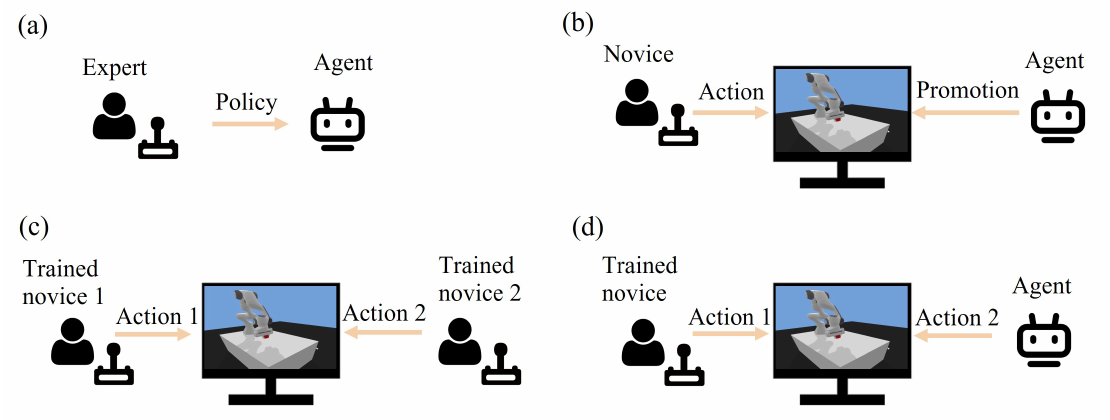
Figure 3. Training and collaboration procedure. ( a ) Expert trains agent. ( b ) Agent trains novice. ( c ) Human cooperates with human. ( d ) Agent cooperates with